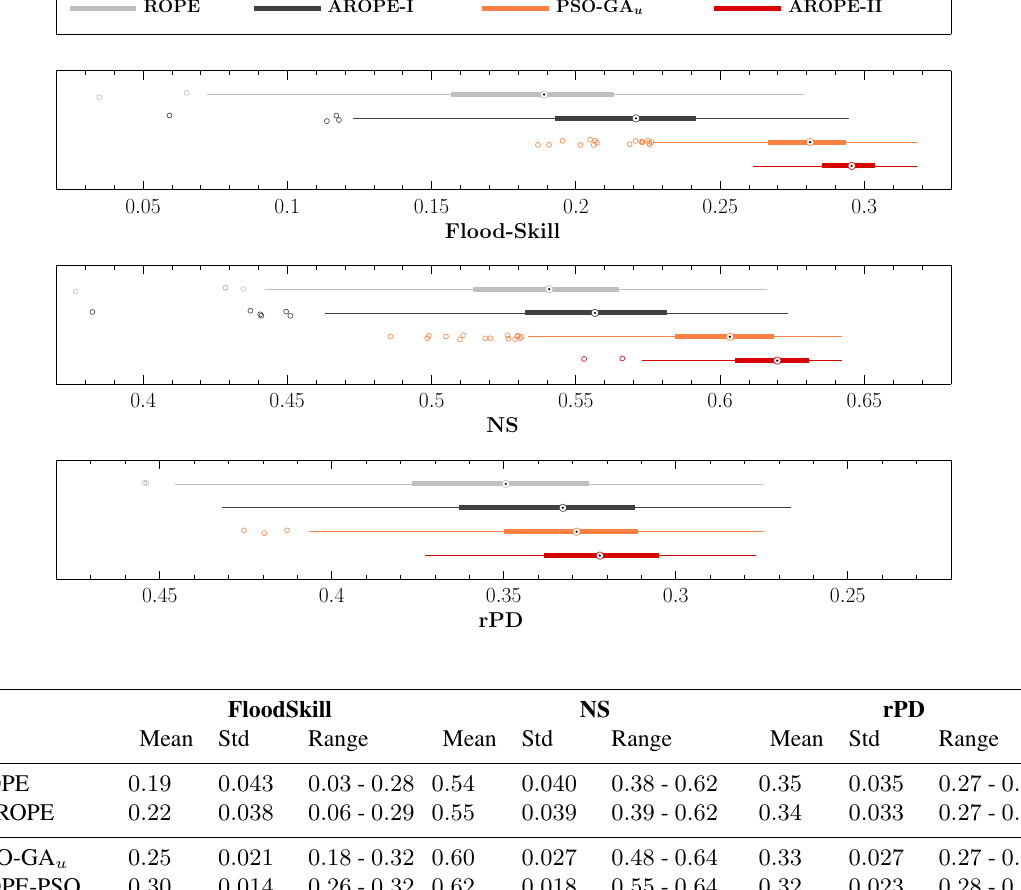
– The case studies in this paper just consider a limited number of calibration parameters parameters. This is sufficient for the given model setup considering the small amount of observation data for flood events. The suggested method might perform even better for cali- bration tasks with a higher amount of useful calibra- tion data or lower process dynamics where the set of good parameter vectors is much more clearly